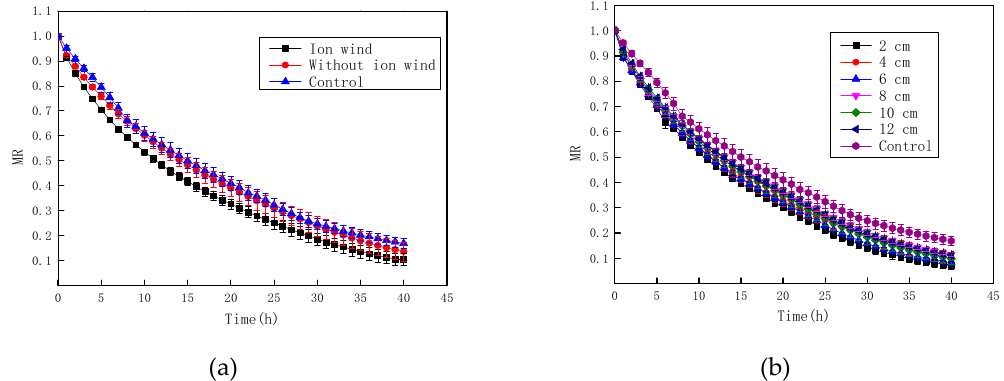
Figure 3. The moisture ratio of Chinese wolfberry fruits. ( a ) Ionic wind and without ionic wind; ( b ) different needle spacing.